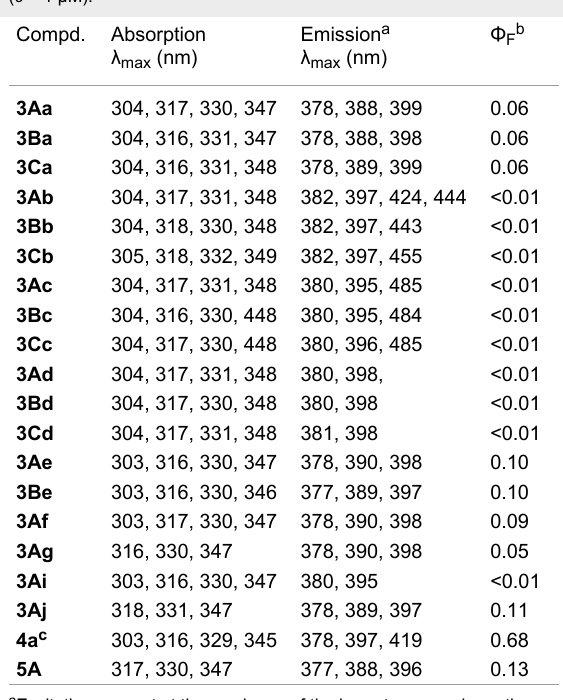
Table 1: Absorption and emission maxima and fluorescence quantum yields ( Φ F ) for the synthesized compounds in chloroform solution ( c = 1 μ M).